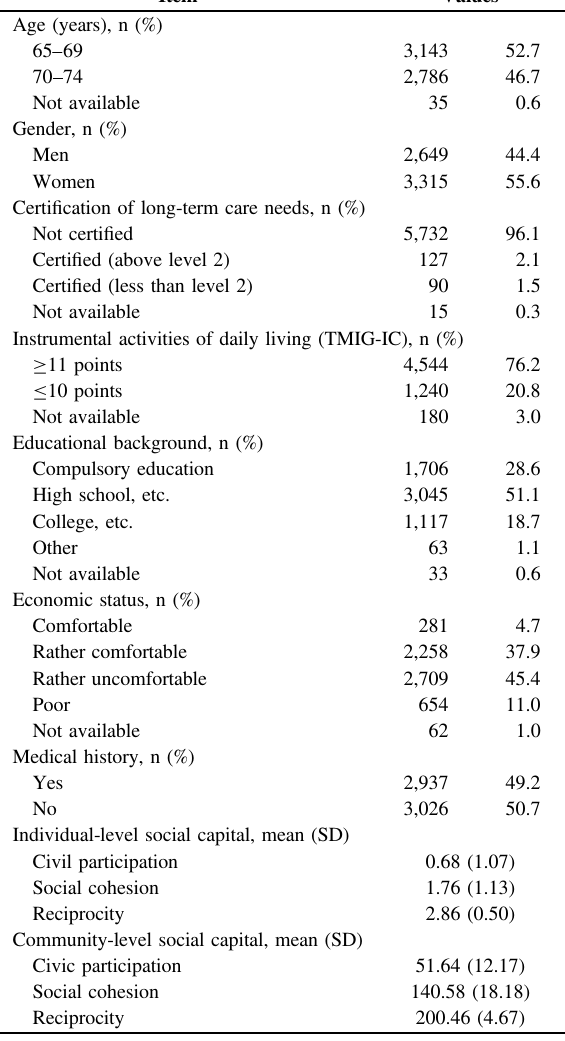
Table 1 Population characteristics (n =